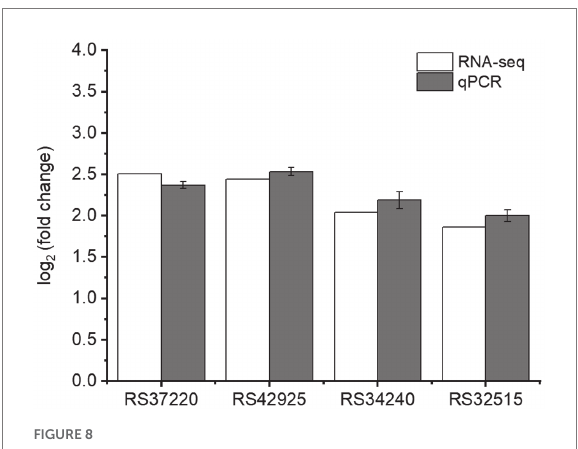
FIGURE 8 Validation of RNA-seq data of selected genes by